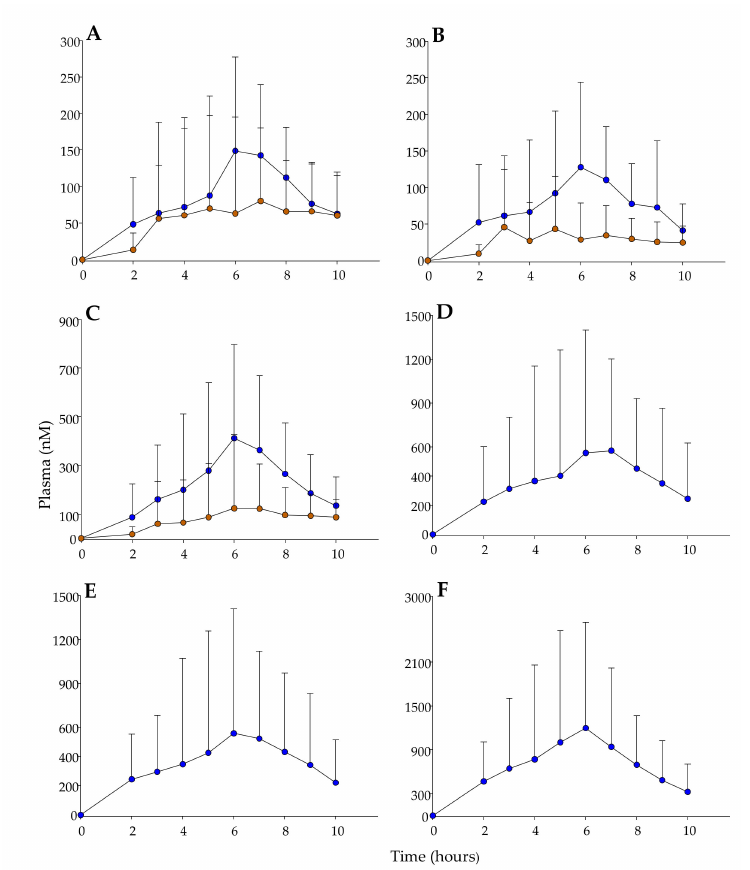
Figure 3. Plasma pharmacokinetic profiles of different metabolites after consuming lemon (blue) or orange (brown) extracts. ( A ) M8 (hesperetin 3 (cid:48) - O -glucuronide); ( B ) M7 (hesperetin 7- O -glucuronide); ( C ) M14 (hesperetin 3 (cid:48) - O -sulfate); ( D ) M2 (eriodictyol glucuronide isomer-2); ( E ) M6 (homoeriodic- tyol glucuronide); and ( F ) M13 (eriodictyol sulfate). Results are expressed as mean ±